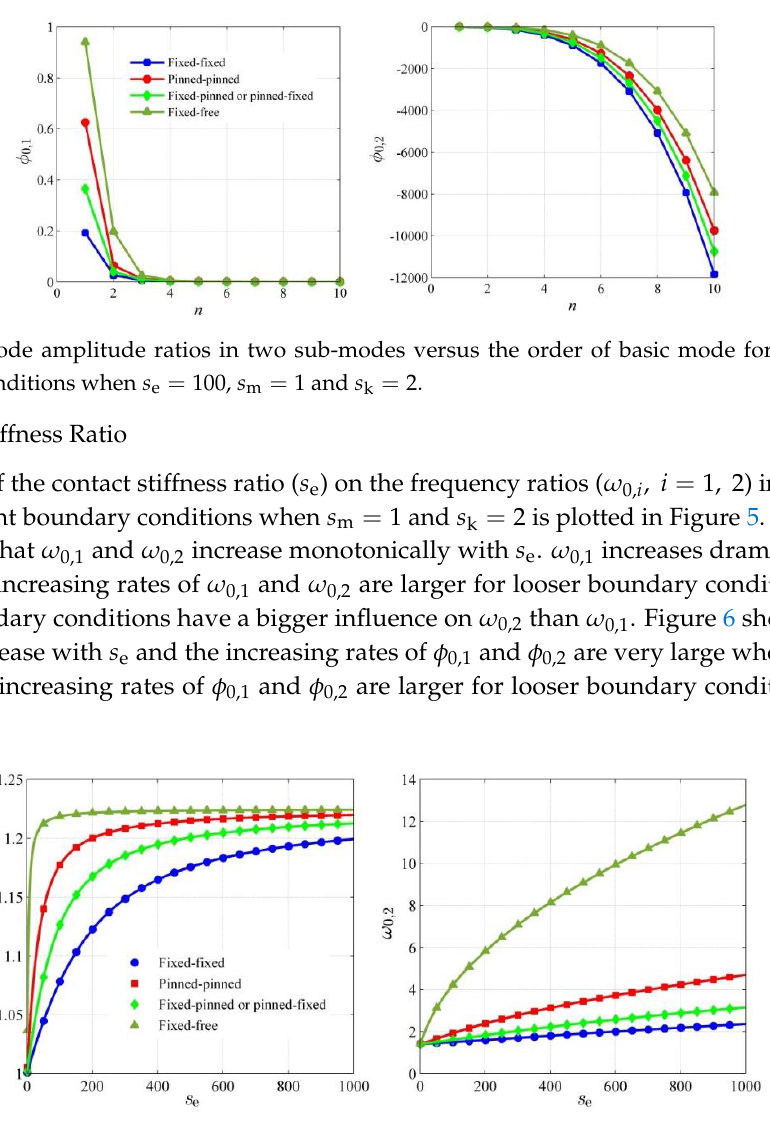
Figure 6. Mode amplitude ratios in two sub-modes corresponding to the 1st basic mode versus contact stiffness ratio ( 𝑠 e ) for different boundary conditions when 𝑠 m = 1 and 𝑠 k = 2 . 2.3.3. Mass Ratio The effect of the mass ratio ( 𝑠 m ) on the frequency ratios ( 𝜔 0,𝑖 , 𝑖 = 1, 2 ) in the 1st basic mode for different boundary conditions is depicted in Figure 7. Both 𝜔 0,1 and 𝜔 0,2 decrease with 𝑠 m and the decreasing rate of 𝜔 0,2 is very large when 𝑠 m is small. Figure 8 shows the effect of 𝑠 m on the mode amplitude ratios ( 𝜙 0,𝑖 , 𝑖 = 1, 2 ) in the 1st basic mode for different boundary conditions. Both 𝜙 0,1 and 𝜙 0,2 increase with 𝑠 m and the increasing rates are large when 𝑠 m is small. 𝜙 0,1 is smaller than 1 when 𝑠 m is smaller than 1 and 𝜙 0,1 is larger than 1 when 𝑠 m is larger than 1. 𝜙 0,2 is smaller than -1 when 𝑠 m is smaller than 1 and 𝜙 0,2 is larger than -1 when 𝑠 m is larger than 1. 𝜙 0,1 and 𝜙 0,2 are closer to 1 for looser boundary conditions, which means that the modes of two beams are closer to each other for looser boundary conditions.